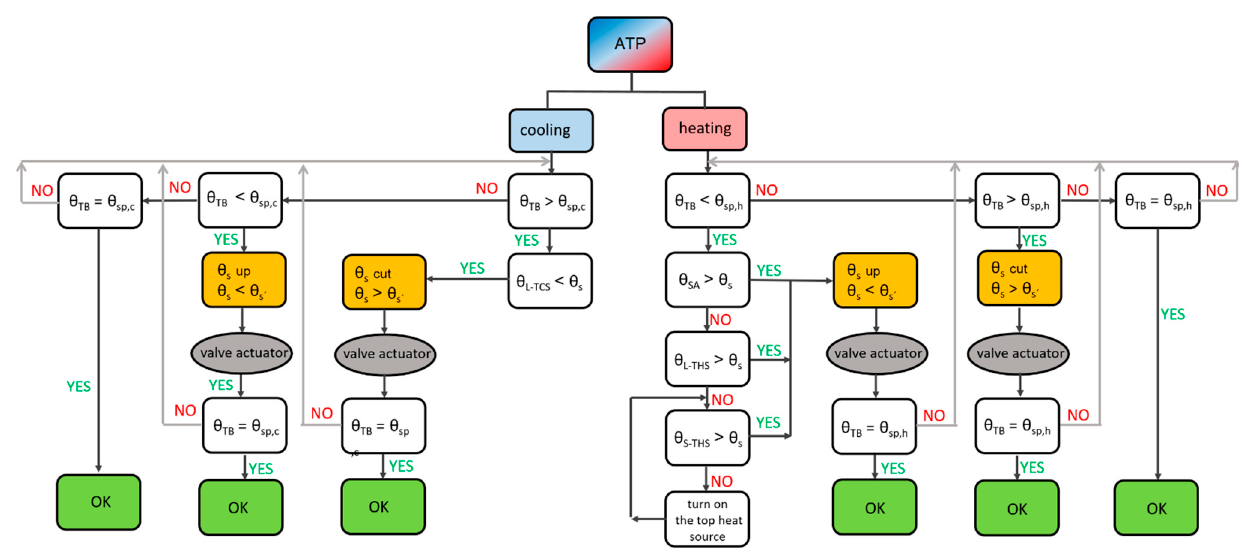
Figure 11. Block diagram of thermal barrier temperature control for active thermal protection func- tion mode. θ TB —thermal barrier temperature; θ sp,h —thermal barrier temperature setpoint—heating mode; θ sp,c —thermal barrier temperature setpoint—cooling mode; θ SA —output solar absorber tem- perature; θ L-THS —output long-term heat store temperature; θ S-THS —output short-term heat store temperature; θ S-TCS —output short-term cold store temperature; θ L-TCS —output long-term cold store temperature; θ s —heating/cooling water supply temperature behind the three-way mixing valve before the controller; θ s ’—heating/cooling water supply temperature behind the three-way mixing valve after the controller.